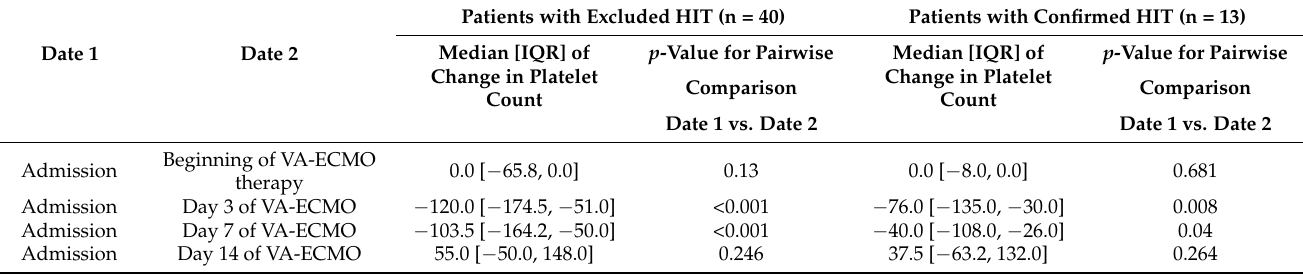
Table 3. Time course of platelet counts.